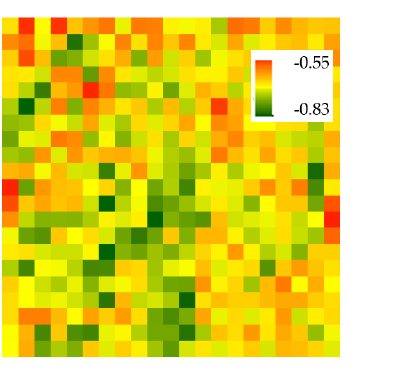
Figure 12. Visualization of the differences.